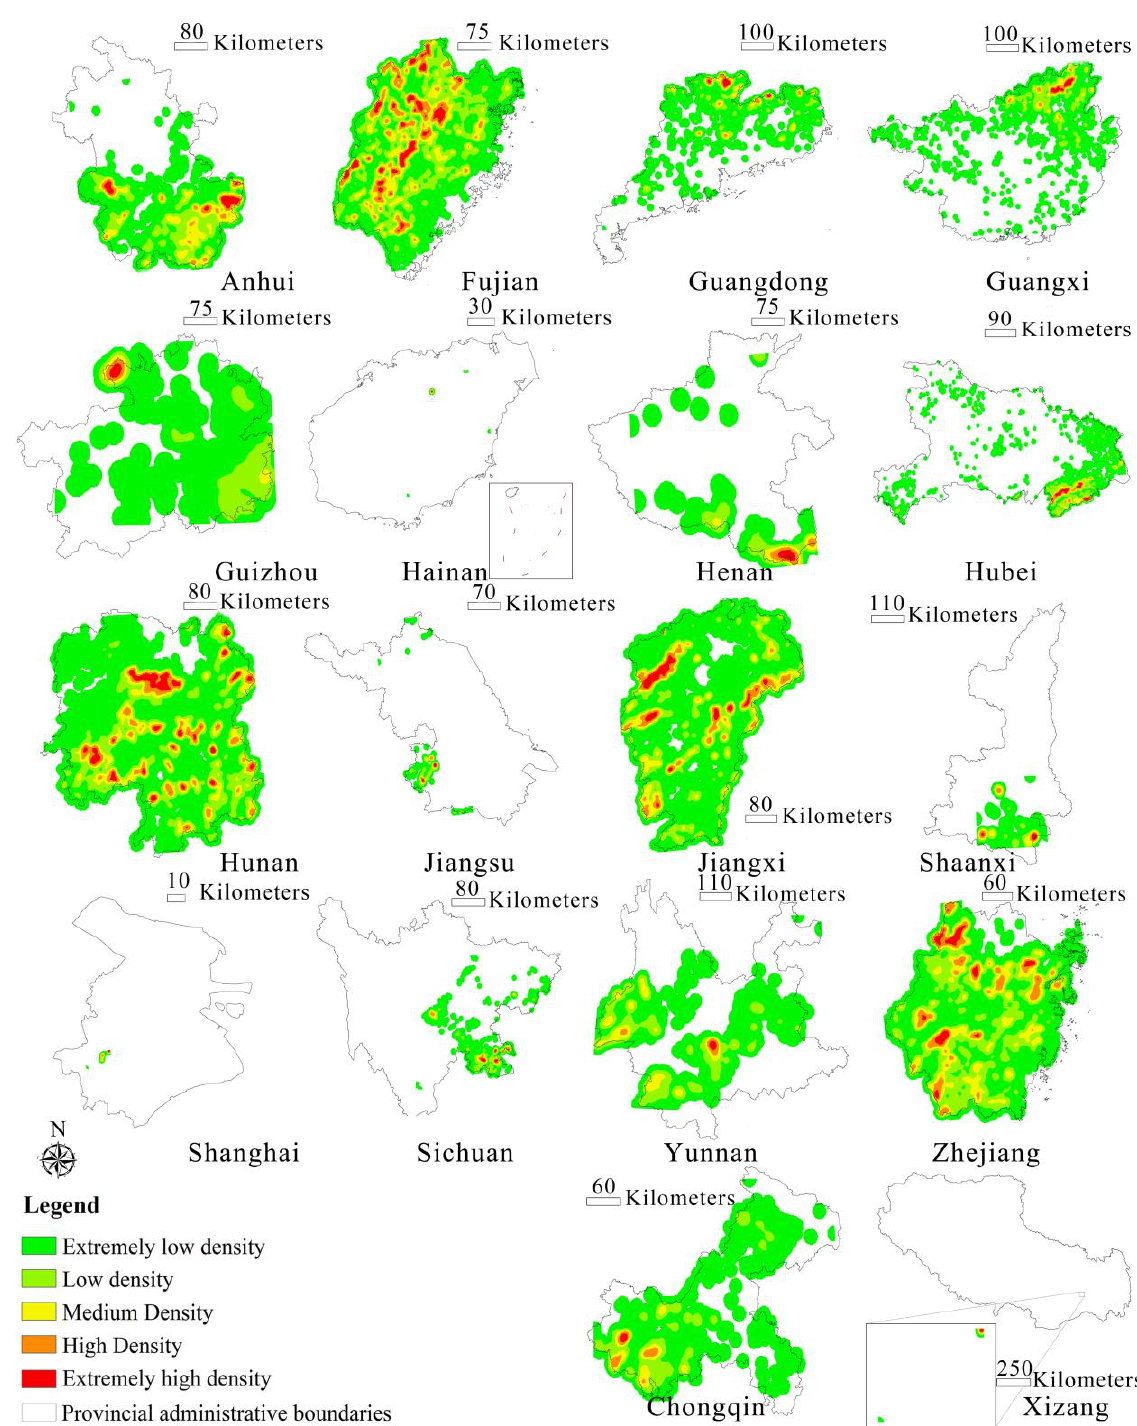
Figure 4. Spatial aggregations of moso bamboo forests by the province in 2015.